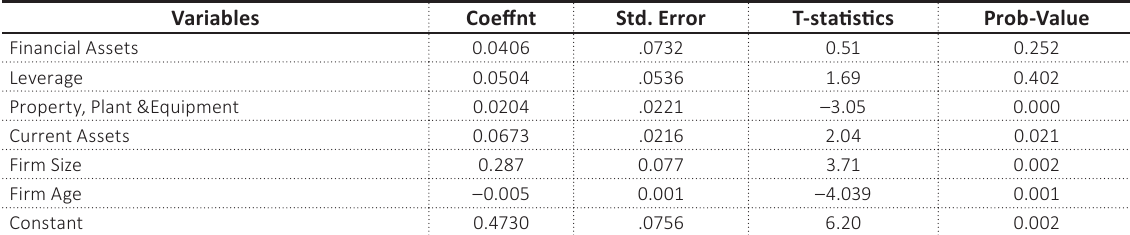
Table 11. Independent variables and dependent variables: Individual level of significance of the variables Variables